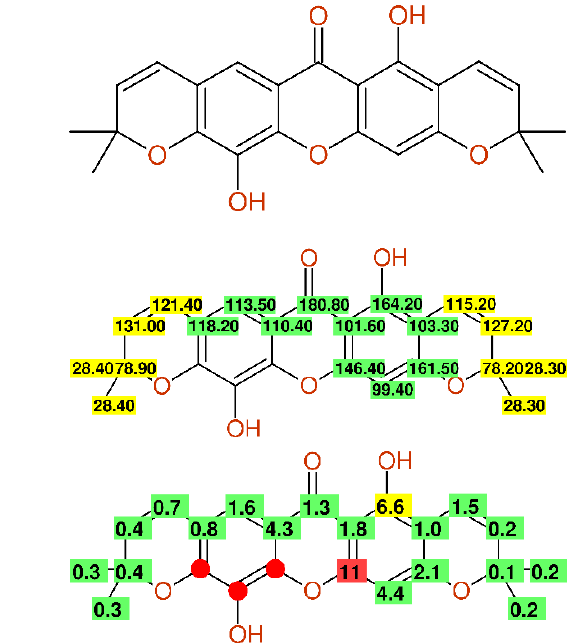
Figure 9. Compound OH-1 from [52] as another example of a misassigned alkyl chain. Experi- mental chemical shift values ( middle ) and the differences between the experimental and predicted chemical shift values ( bottom ).